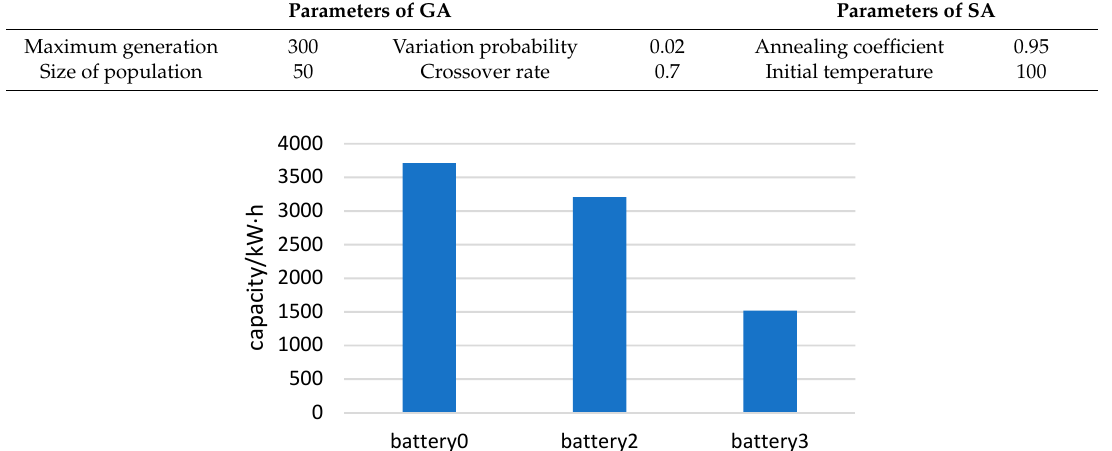
Table 1. Parameters of the Genetic Algorithm (GA) and the Simulated Annealing (SA).